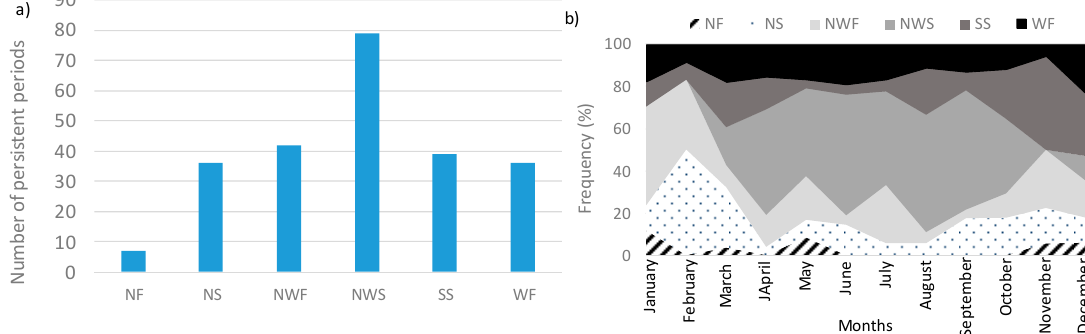
Figure 10. ( a ) The number of persistent periods within each airflow pattern, and ( b ) monthly frequency during the 2009–2018 period.